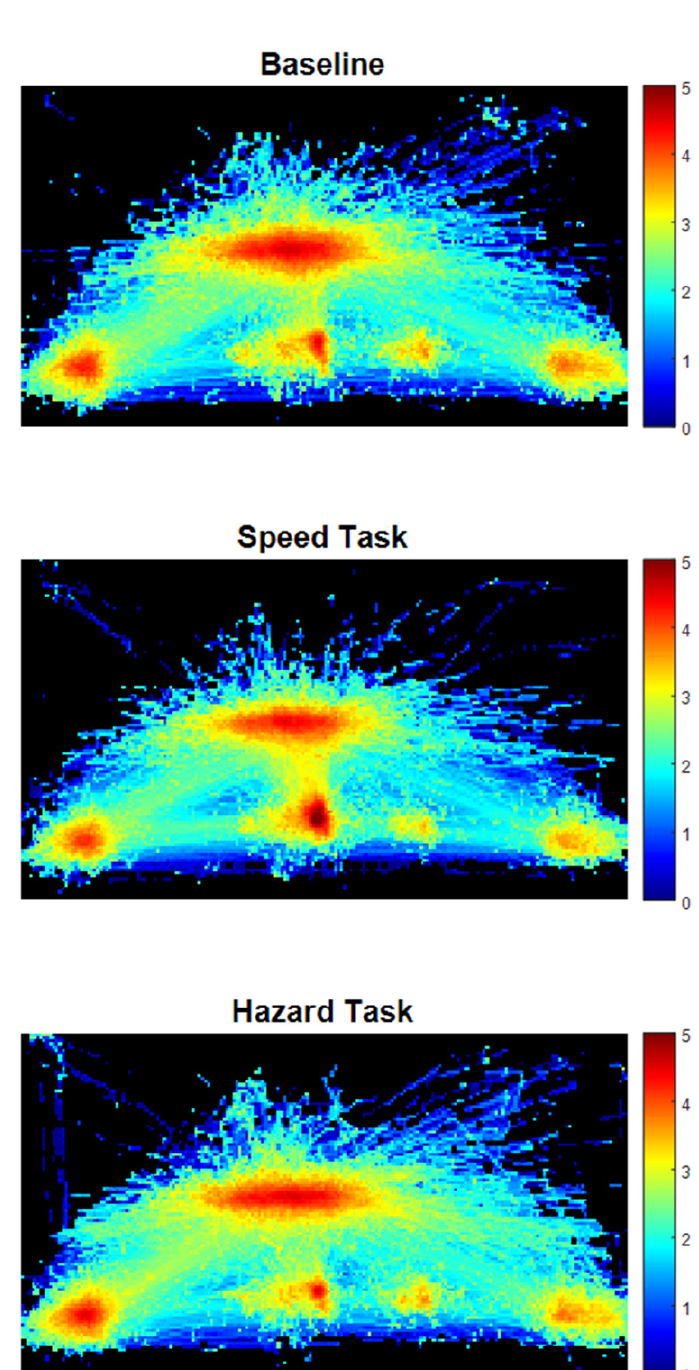
Figure 2. Heatmap of gaze points for the three videos aggregated for the Baseline Task ( top ), Speed Task ( middle ), and Hazard Task ( bottom ). The heatmap was divided into 10 × 10-pixel squares and normalized. The colors are on a base-10 logarithmic scale. For example, a dark red color (value = 5) means there was 100 times more attention to that region than a yellow color (value = 3).